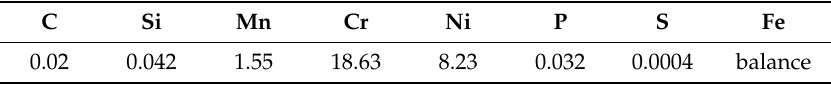
Table 1. Chemical composition of the base metal wt.%.